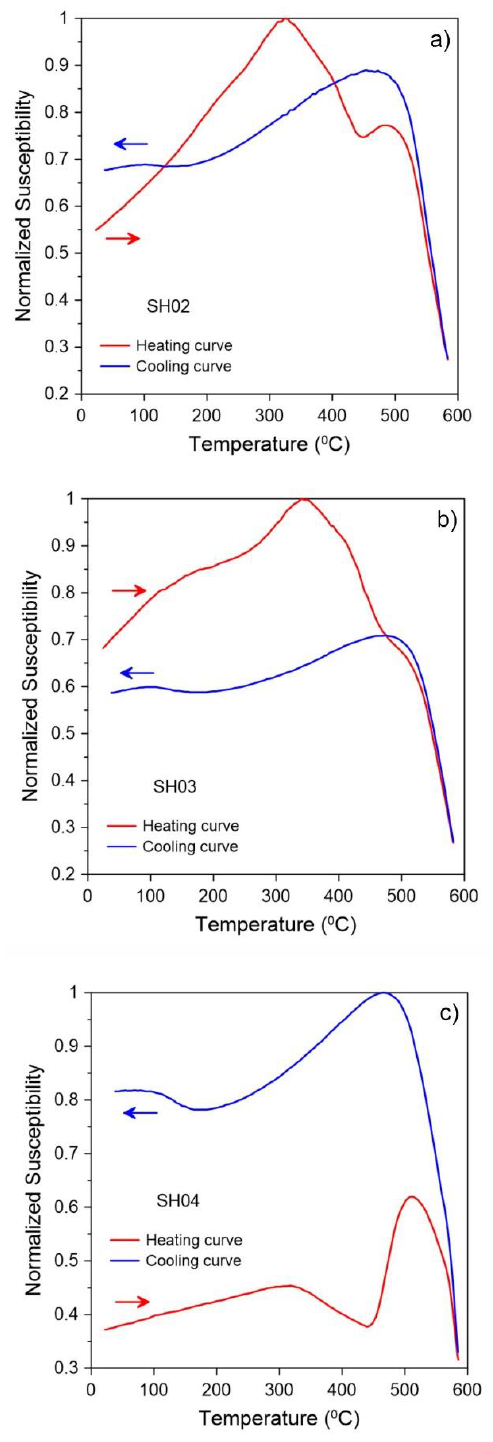
Figure 4. Representative continuous thermomagnetic measurements for La Playa representative samples. The Red (blue) branch corresponds to the heating (cooling) cycle.